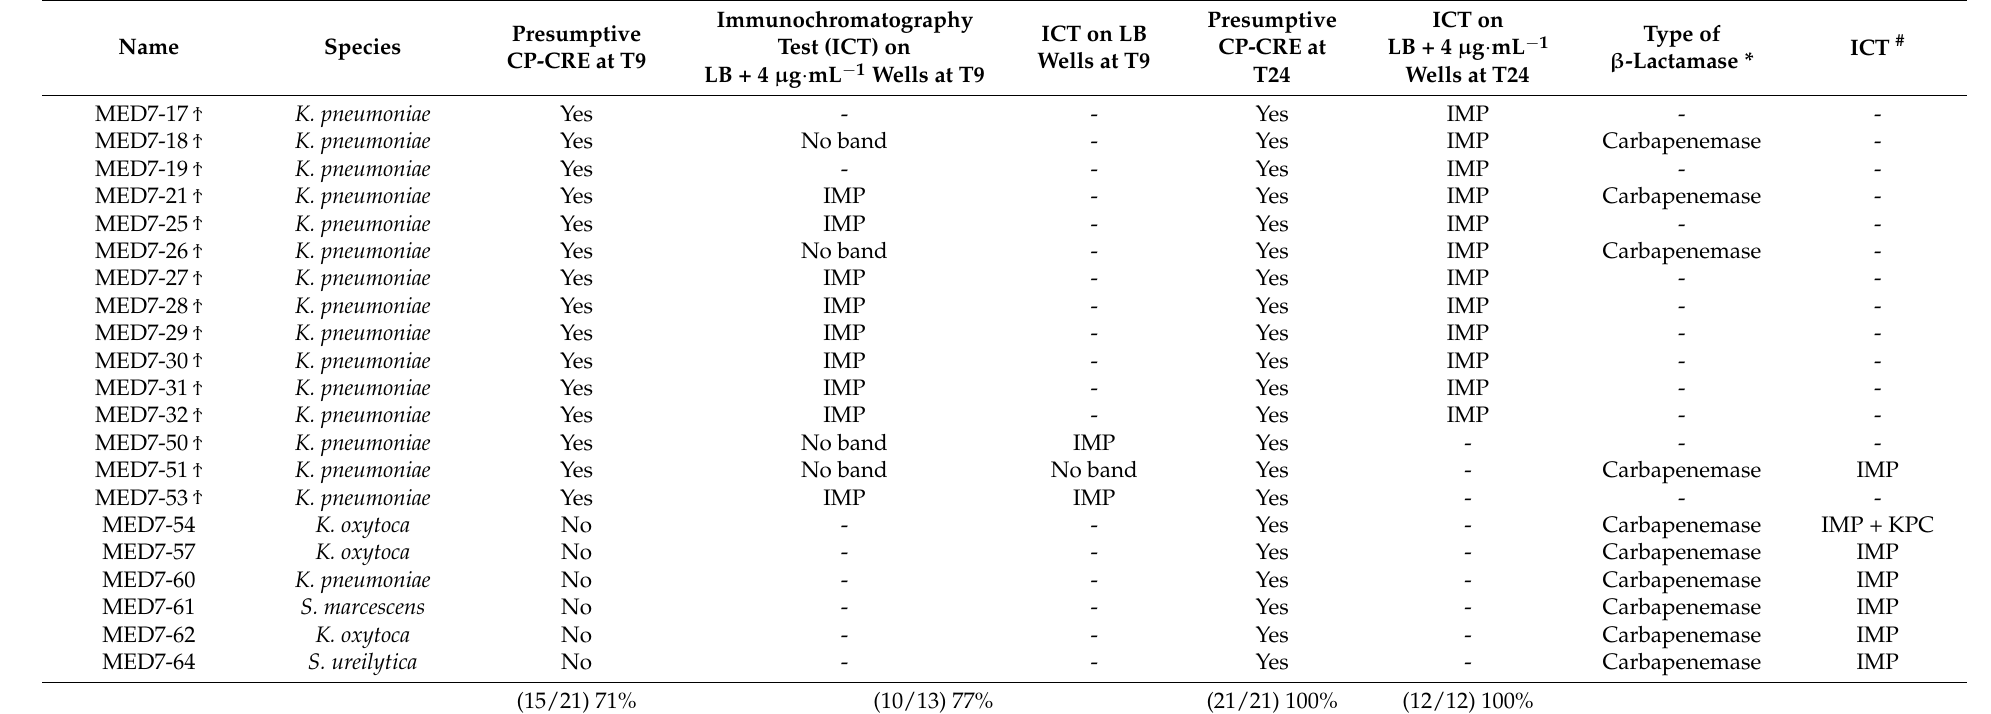
Table 5. CP-CRE from MED7 sample where Tn stands for n hours of